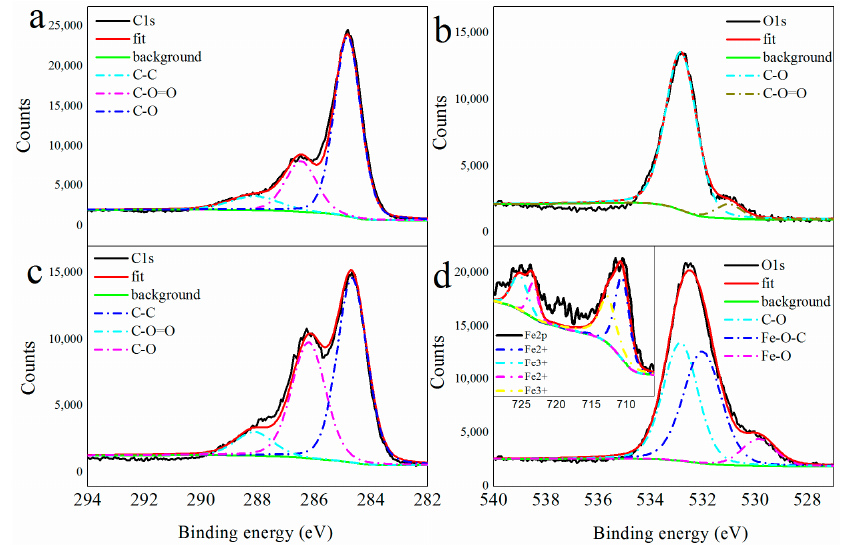
Figure 6. X-ray photoelectron spectroscopy (XPS) spectra of GO and sample No. 1. ( a ) C1s spectrum, ( b ) O1s spectrum of GO, ( c ) C1s spectrum, and O1s spectrum ( d ) of sample No. 1. The inset of ( d ) shows the Fe2p spectrum of sample No. 1. The black line shows the original data, the red line shows the fitted curve of black line, and the other color dot lines are fitted curves for different specific bonds. Crystals 2018 , 8 , x FOR PEER REVIEW